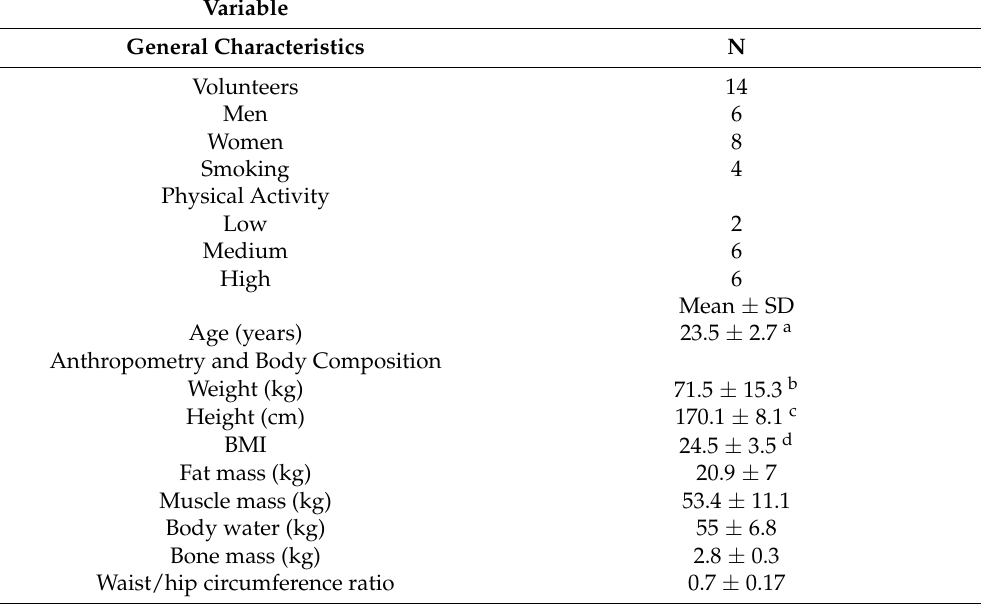
Table 2. The baseline characteristics of